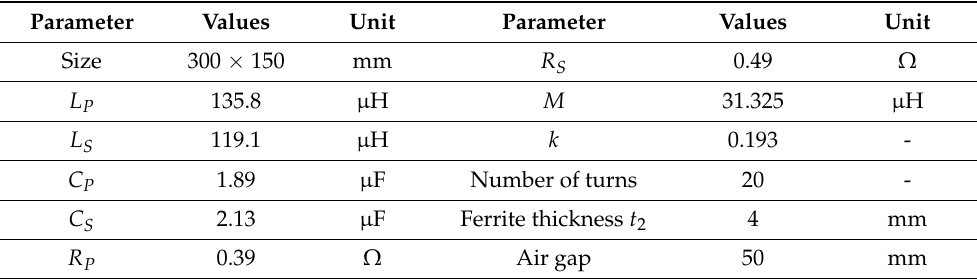
Table 8. Design and experiment parameters of the optimized square couplers.